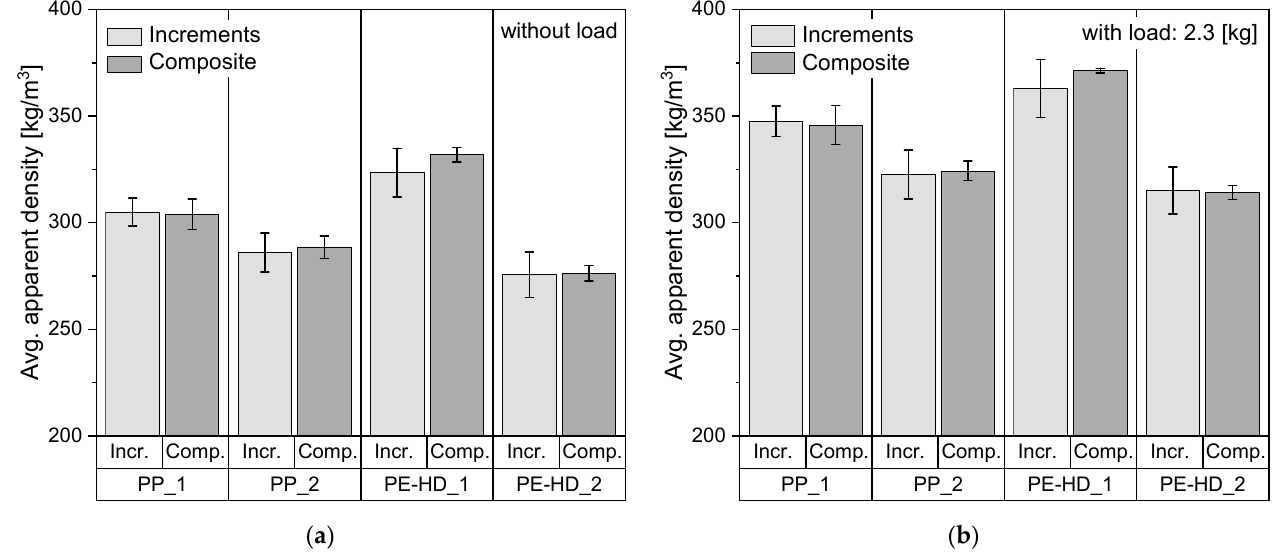
Figure 11. A comparison between the average values of the grouped increment samples and the respective composite samples of the PO feedstocks based on the analysis of variance (ANOVA). ( a ) average AD values of loose samples without a weight load, ( b ) average AD values of compacted samples with a weight load of 2.3